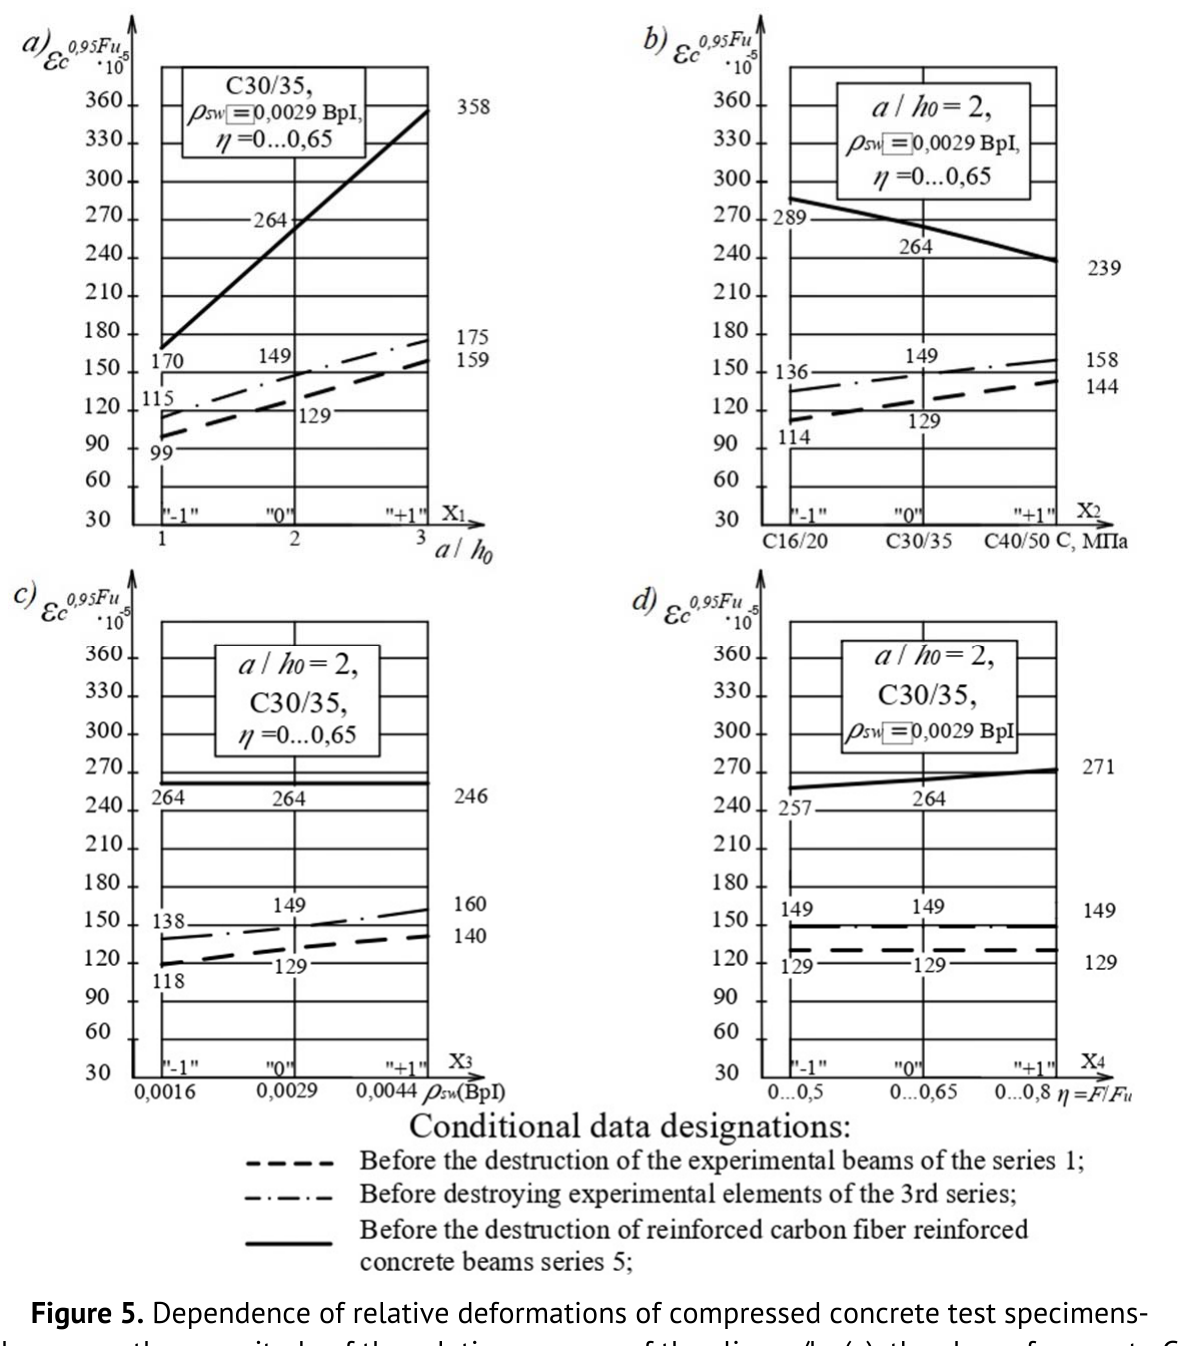
Figure 5. Dependence of relative deformations of compressed concrete test specimens- beams on the magnitude of the relative passage of the slice, a/h (a), the class of concrete C 0 (b), the number of transverse reinforcement ρ (c), the level of low-cycle reloading (d). sw Average relative deformation values of the compressed concrete in the middle part of beams after their stabilization under low-cycle static